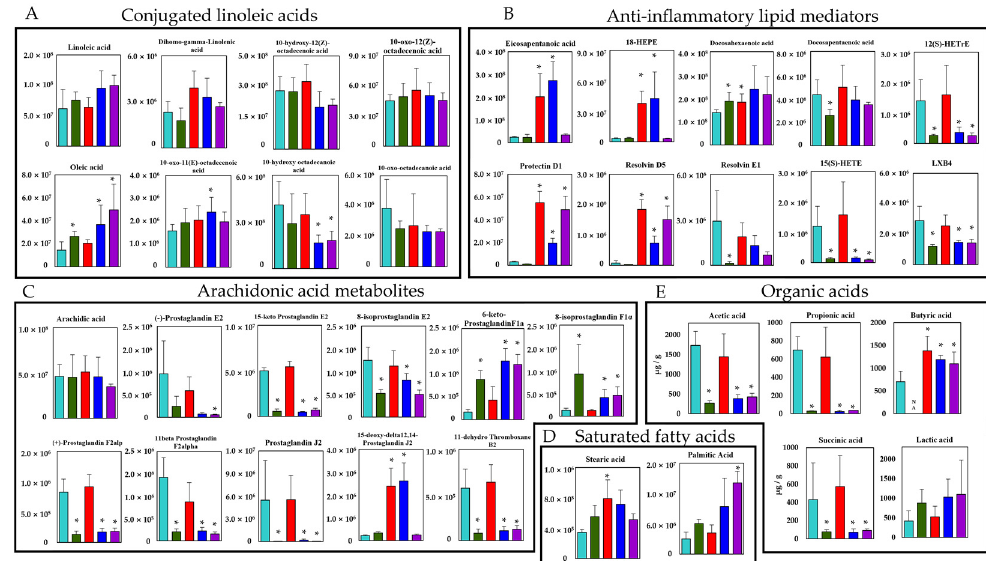
Figure 3. Verification of the butyric acid and EPA-related metabolites inducing efficacy by CBM 588 based on targeted long-chain fatty acid metabolites profiles. Metabolic pathway for PUFAs and SCFAs in mouse colon contents. The signal intensities of metabolites were compared using the average values of each group. The vertical axis indicates the signal intensity. The vertical axis of the SCFAs is the concentration ( µ g/g). ( A ) Conjugated linoleic acid ( B ) Anti-inflammatory lipid mediators. ( C ) Arachidonic acid metabolites. ( D ) Saturated fatty acids. ( E ) Organic acids. Values represent mean ± SD ( n = 5). Statistical significance was set at p < 0.05. * p < 0.05, compared with control. HEPE: hydroxyeicosapentaenoic